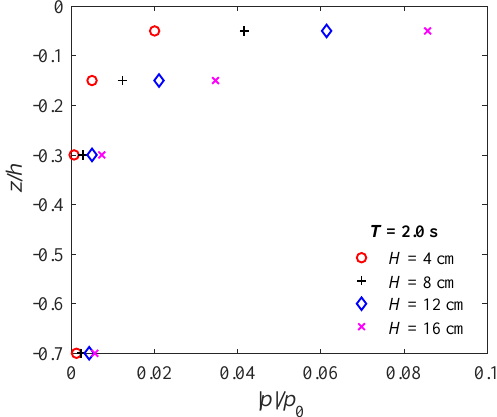
Figure 10. Distribution of the maximum pore-water pressures vs soil depth ( z ) in front of the pile for various wave heights ( x = 0.15 m, T = 2 s, Points 11, 12, 13, and